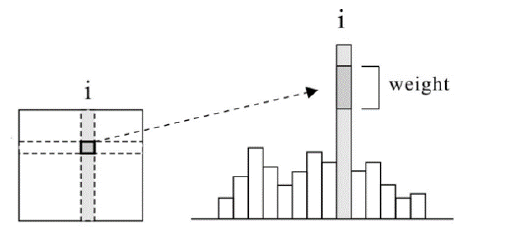
Figure 2. Scheme of weighted median filter histogram formation.